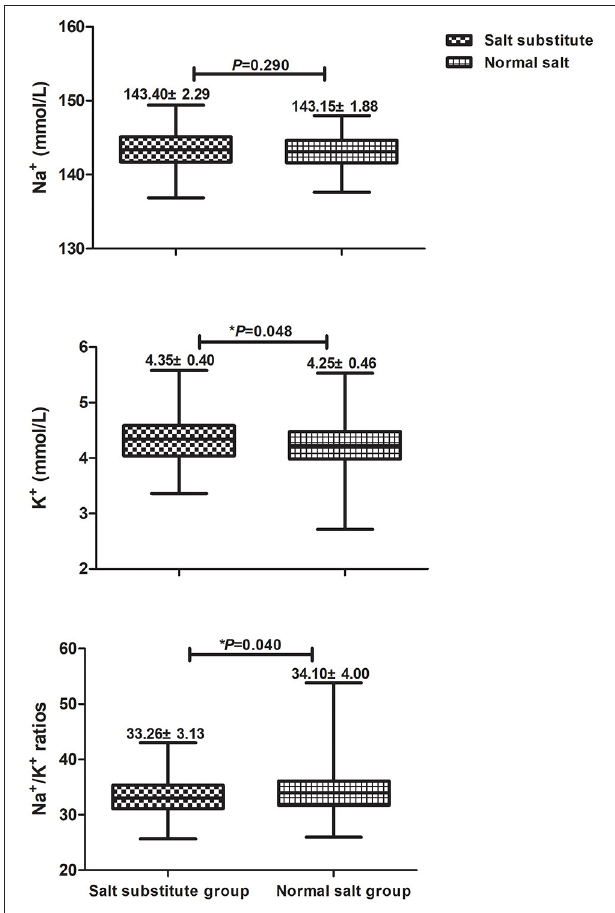
FIGURE 3 | Comparisons for urinary Na + , K + , and Na + /K + ratios between salt substitute group and normal salt